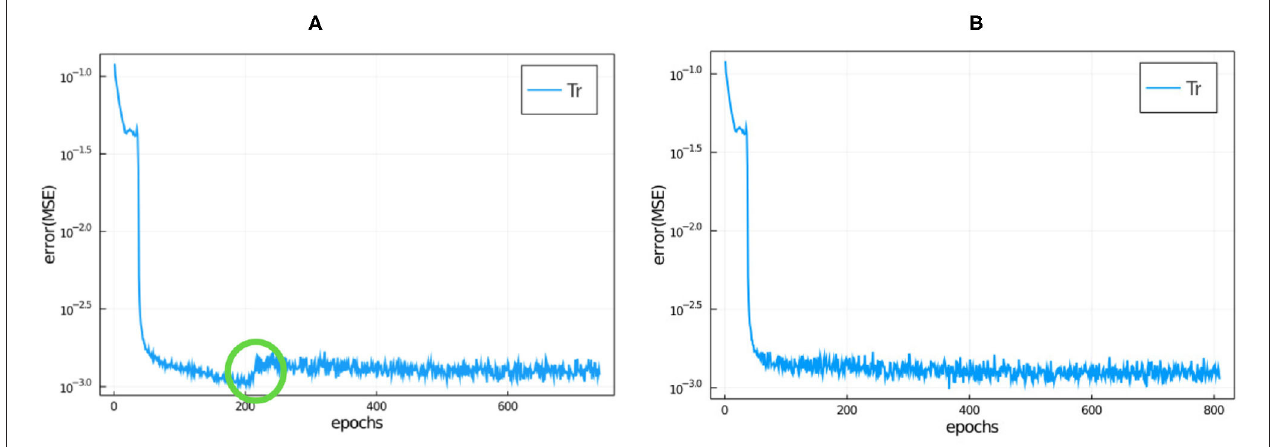
FIGURE 4 | Training loss function vs. epochs for model 9 (the hyperparameters are specified in Table 2 and the NN details are described in the main text) without roll-back (A) and with roll-back (B) using the same seed. We have circled in green where a jump occurred during this training run (see main text for discussion).